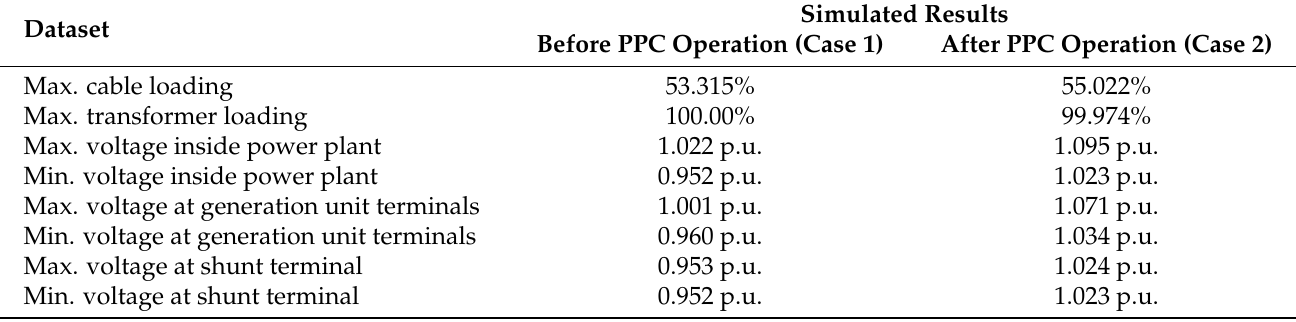
Table 3. Simulated results for PQ-analysis before/after PPC